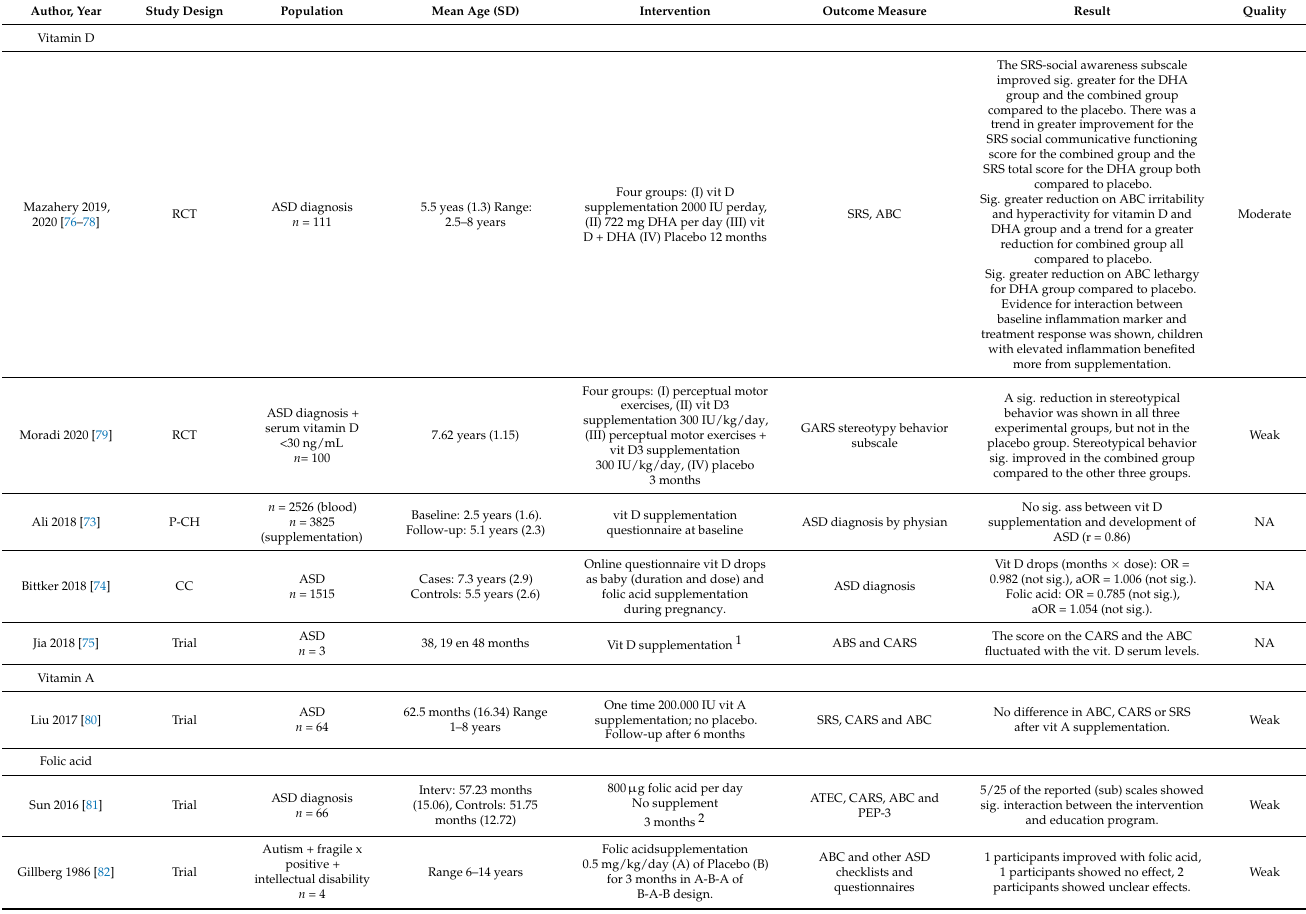
Table 7. Studies concerning vitamin/mineral supplementation for ASD, that are not included in the meta-analyses and systematic reviews in Table 6.